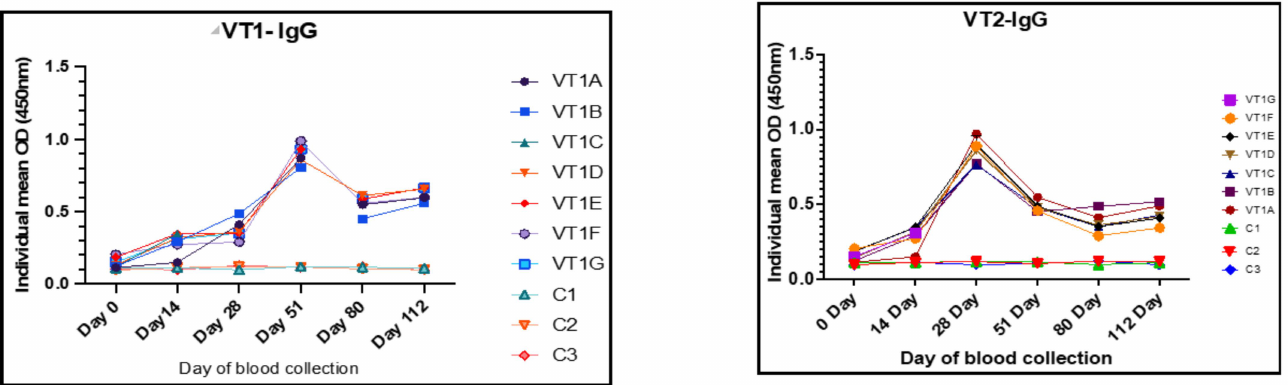
Figure 7. Humoral immune responses (IgG) on different time points in VT1- and VT2-immunized rabbits at doses of 50 µ g and 100 µ g, respectively. Different color dots represent mean of the individual animal (A-G) for immunized and C (1–3) for each control animal.